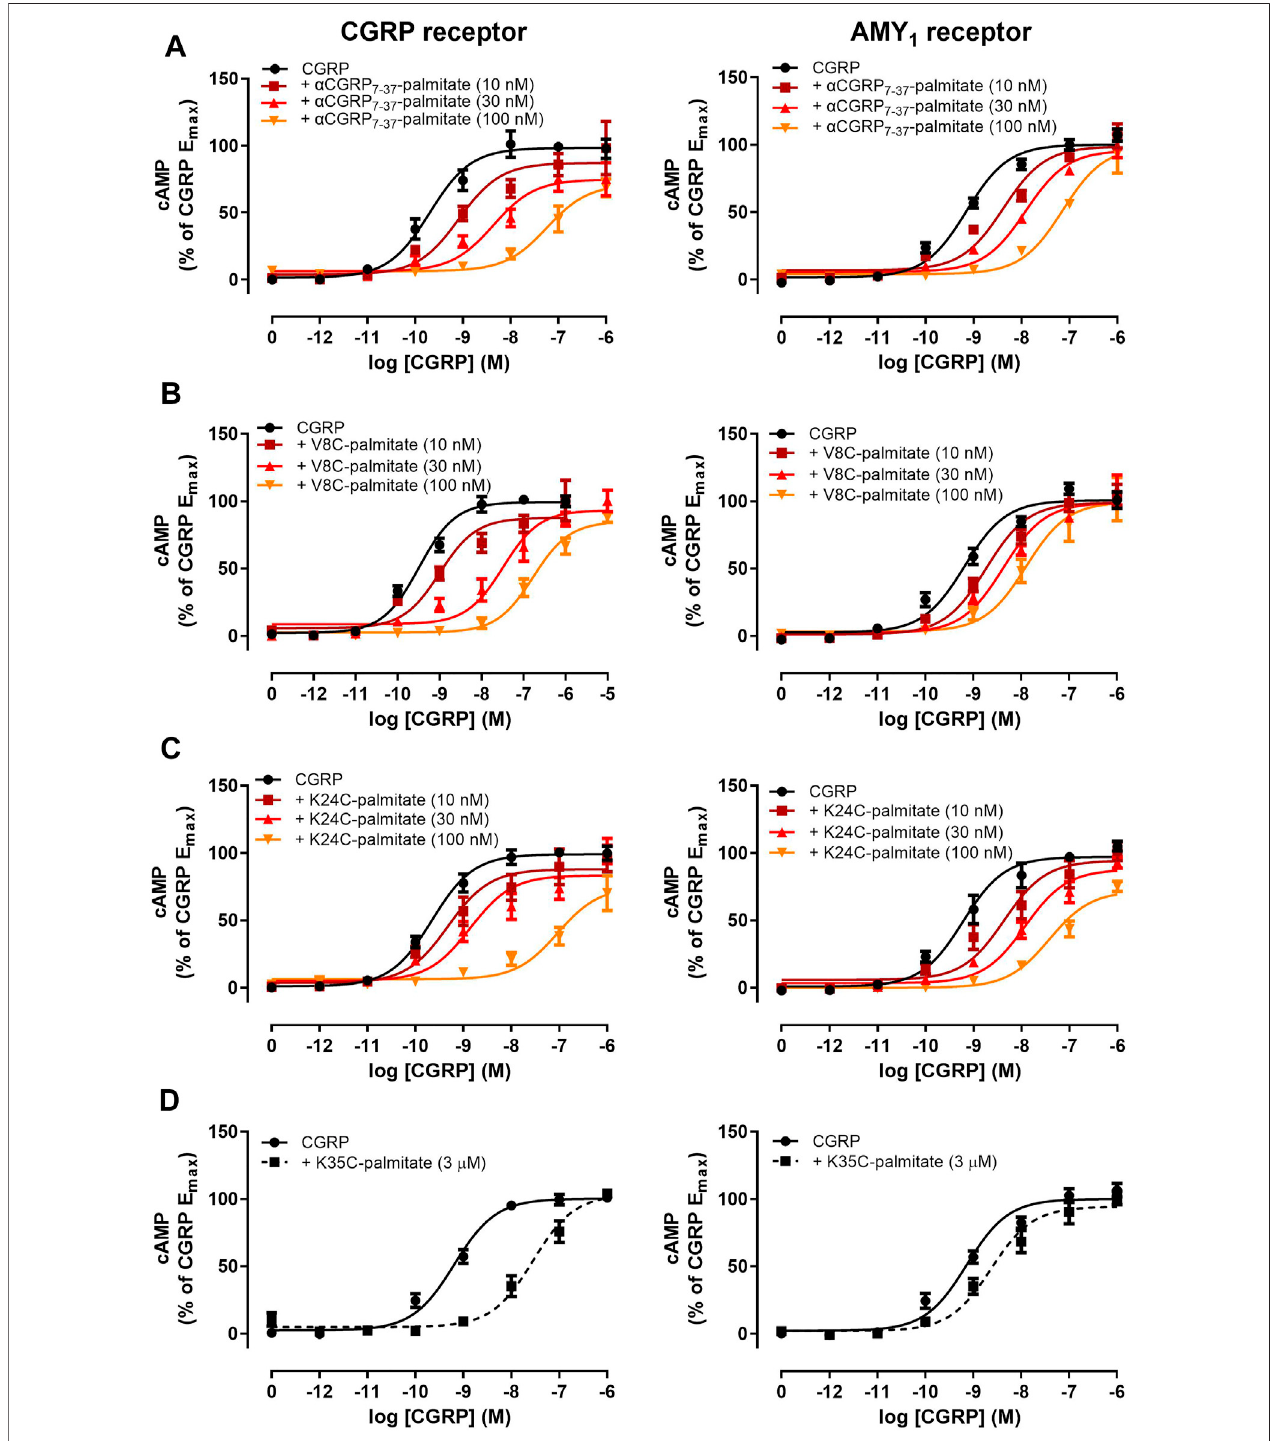
FIGURE 3 | Antagonism of CGRP-stimulated cAMP production by lipidated α CGRP 8-37 analogues at human CGRP or AMY 1 receptors expressed in Cos-7 cells. Concentration-response curves were generated in the absence or presence of (A) α CGRP 7-37 -palmitate, (B) V8C-palmitate, (C) K24C-palmitate, and (D) K35C- palmitate at one or multiple different concentrations. Data points are plotted as a percentage of maximal CGRP-stimulated cAMP production as mean ± SEM of four to fi ve independent experiments.